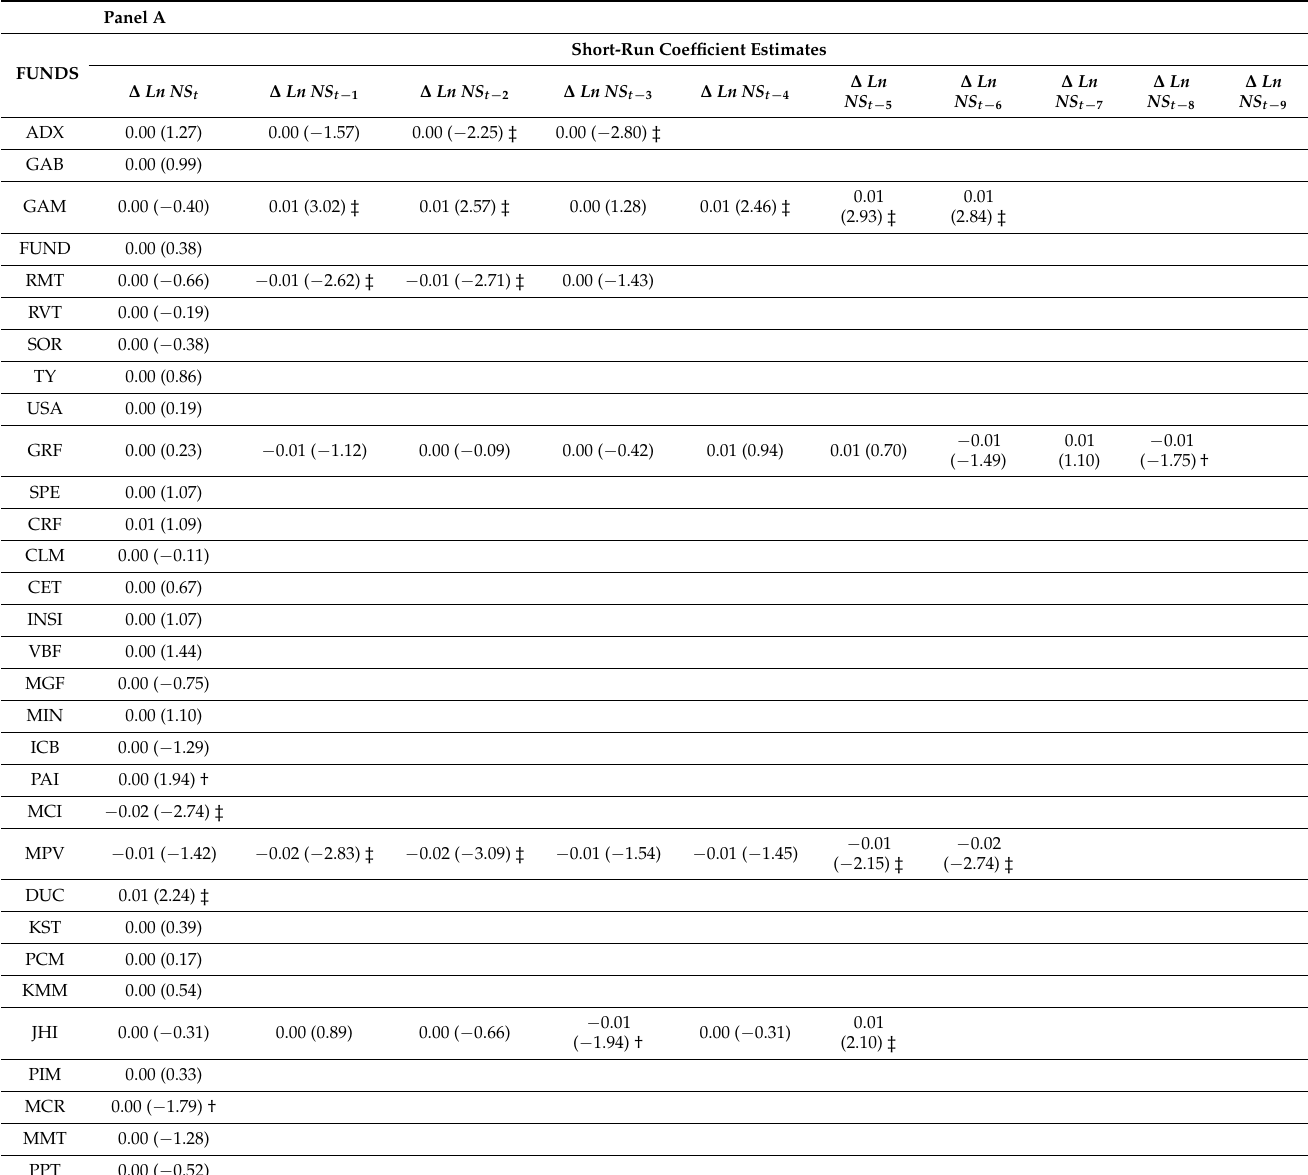
Table 7. Short-Run Coefficient Estimates—Linear ARDL—Model P = f (NAV,